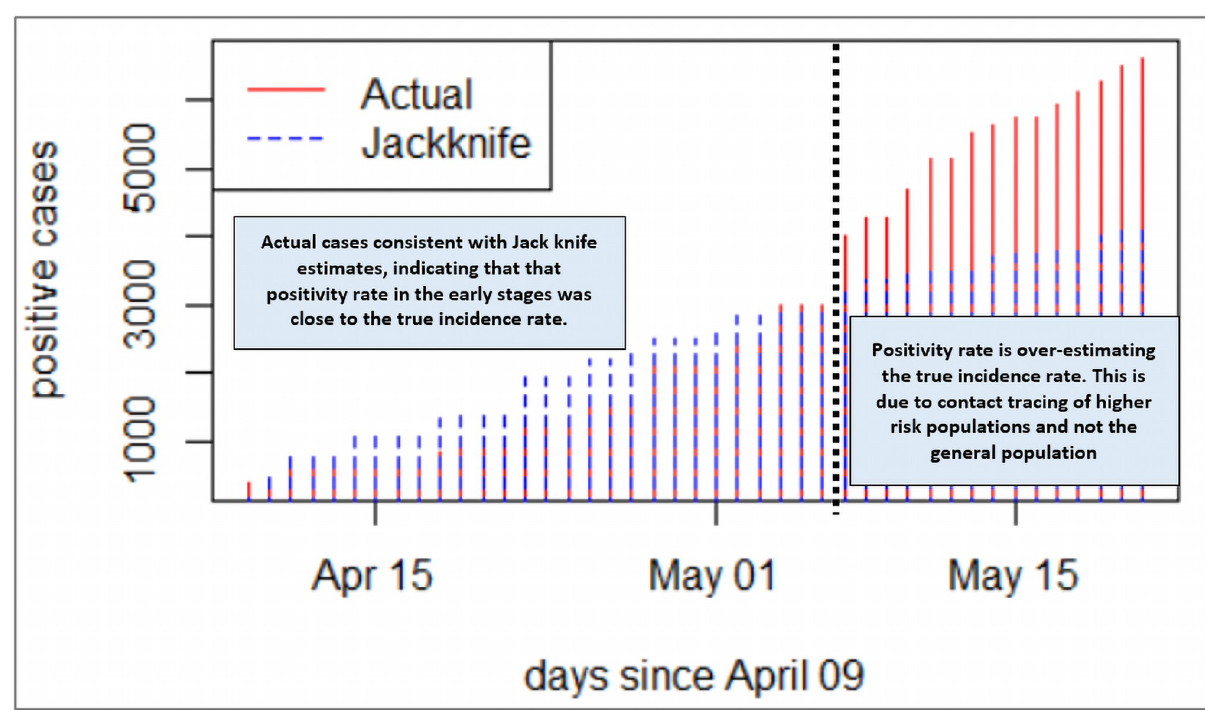
Fig 2. Jackknife estimates versus actual number of positive cases.